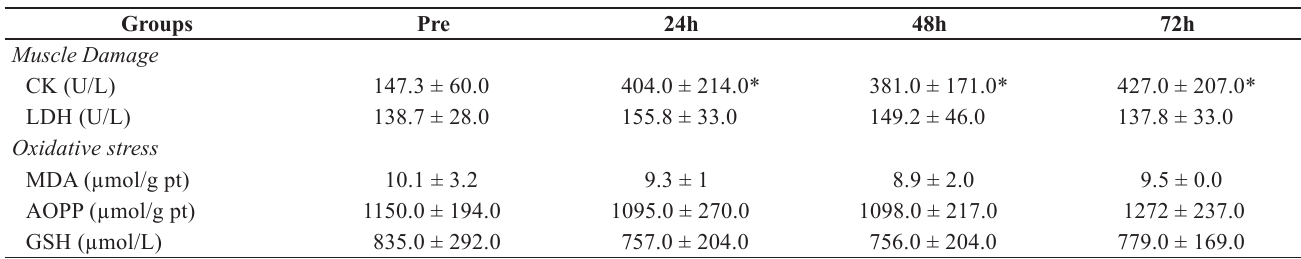
Table 2. Markers of muscle damage and oxidative stress determined pre, 24, 48 and 72h after the training session.